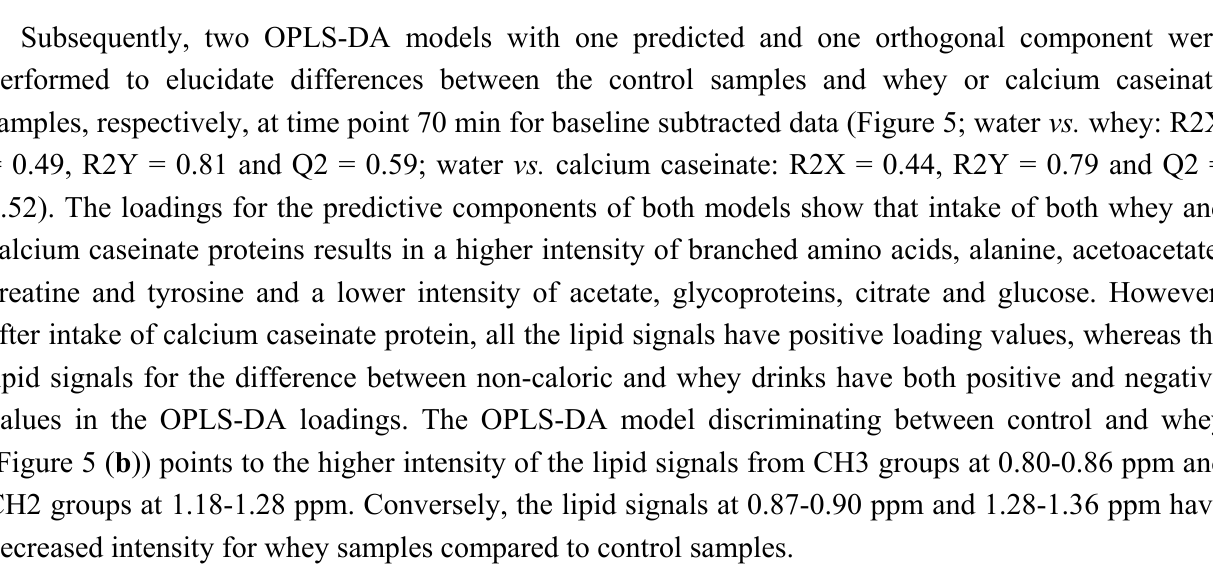
Figure 5. OPLS-DA score plots discriminating between control and whey ( a ) and calcium caseinate ( b ) at 70 min (baseline subtracted) after a bout of heavy resistance. Corresponding loading plot describing the component for OPLS-DA models of control vs.